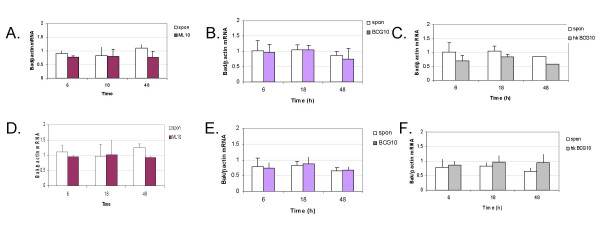
M. leprae-, and BCG- induced time course expression of Bad and genes. THP-1 cells were infected with M. leprae, live and heat-killed BCG for 6, 18 and 48 h at MOI of 10 each. RNA was extracted, converted to cDNA and PCR carried out for Bad, Bak and β-actin genes. Graphs illustrate results obtained from the mean of 3 independent experiments. A, D. M. leprae-, B, E. live BCG- and C, F. heat killed BCG-induced Bad/βactin and Bak/βactin mRNA expression ratios; Spon (unstimulated cells).